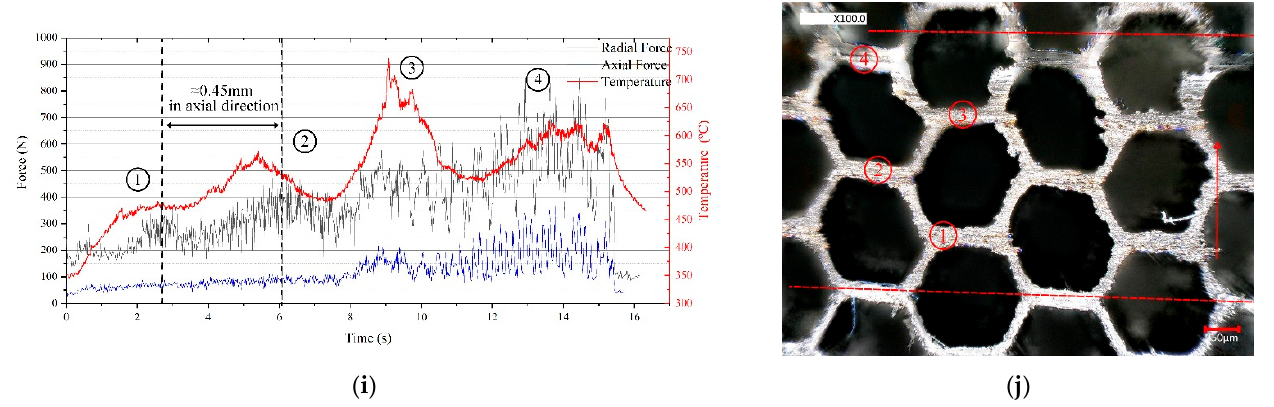
Figure 5. The rubbing forces and temperature and the wear grooves of the honeycomb at different axial incursion rates; ( a , b ) only radial rub; ( c , d ) 60 μ m/s; ( e , f ) 80 μ m/s; ( g , h ) 100 μ m/s; ( i , j ) 120 µ m/s; ( a ) is cited from reference [16].